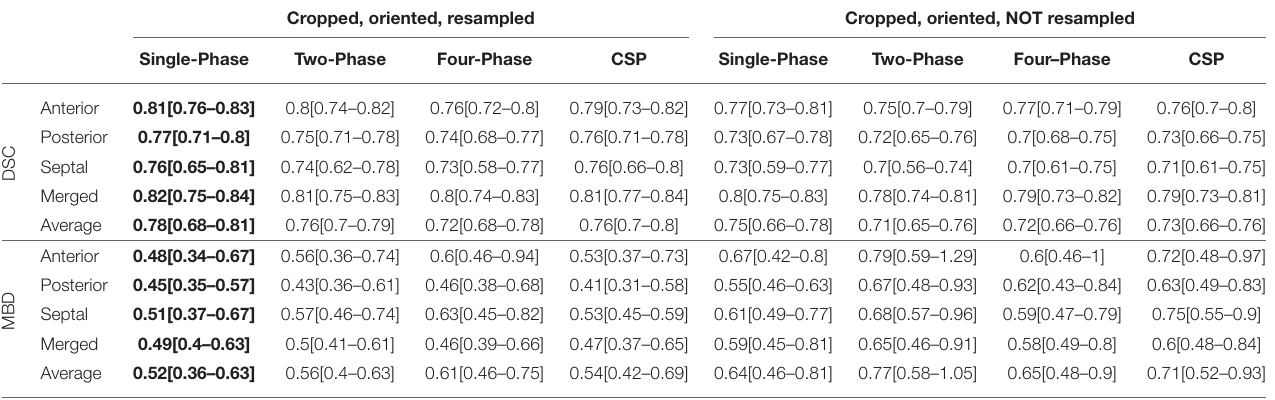
TABLE 3 | Inference Results Using the Commissural Landmarks across all stages of repair.